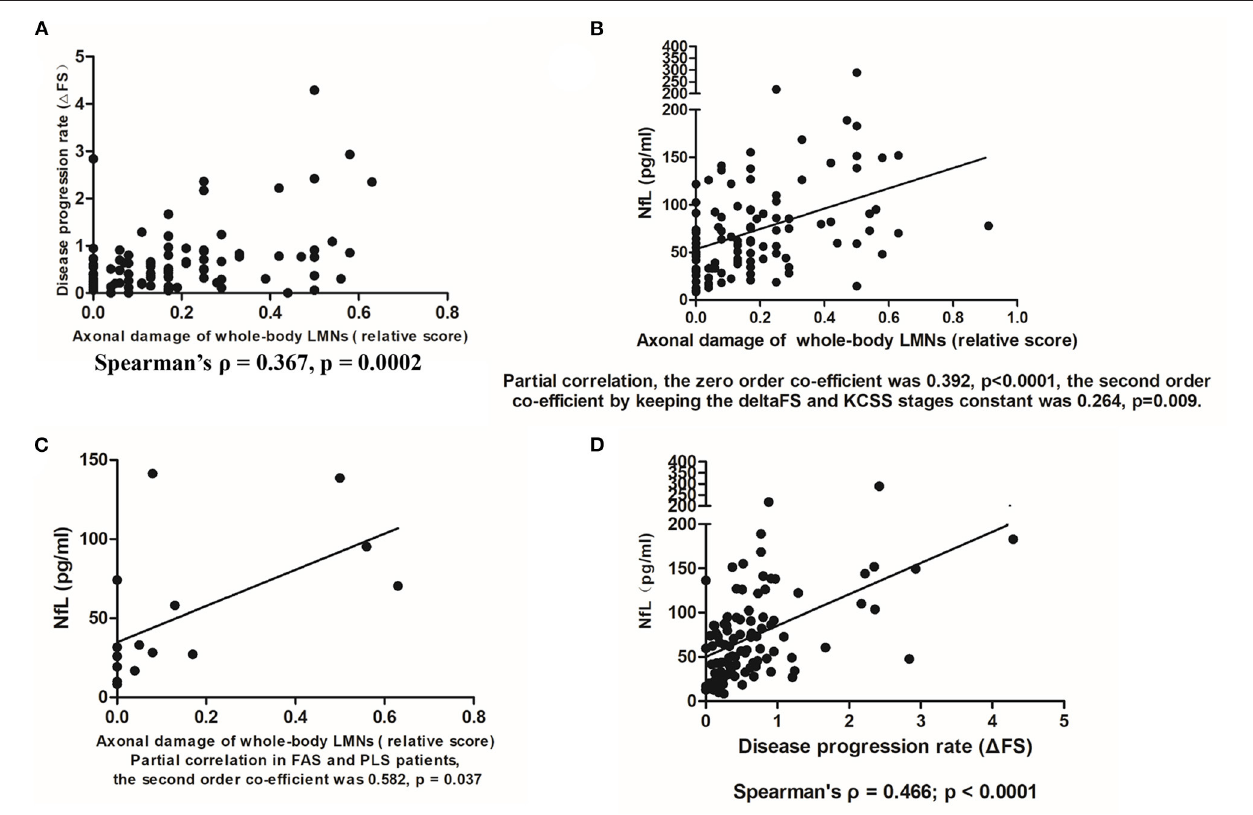
FIGURE 2 | (A) Correlation between the relative score and disease progression rate ( 1 FS) ( N = 103). (B) The positive correlation between serum NfL levels and axonal damage of whole-body LMNs (indicated by the relative score) ( N = 103). (C) The positive correlation between serum NfL levels and axonal damage to whole-body LMNs in FAS or FLS patients ( N = 15). (D) The positive correlation between serum NfL levels and disease progression rates from disease onset to serum sampling ( 1 FS) ( N =